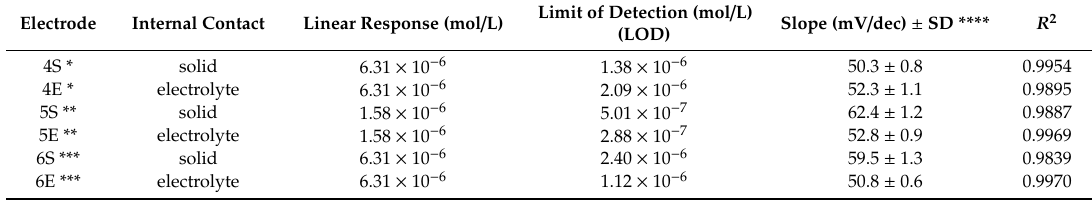
Figure 2. Potentiometric response of internal electrolyte contact LaF 3 electrodes with Fe x O y NPs. Table 2. The response characteristics of electrodes with Fe x O y NPs.